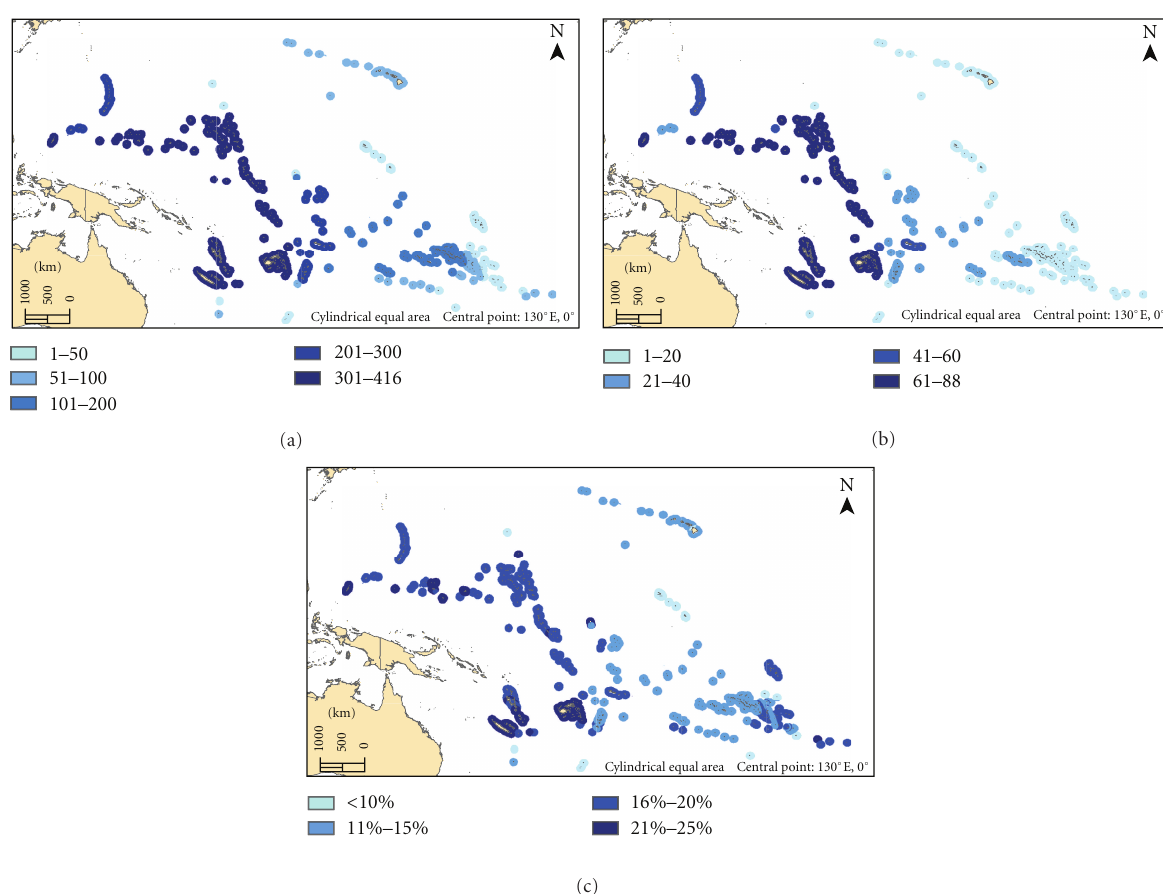
Figure 3: (a) Species richness of coral species present in Oceania, (b) species richness of coral species in threatened categories, and (c) proportion of coral species in threatened